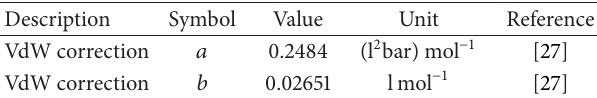
Table 4: Van der Waals constants for